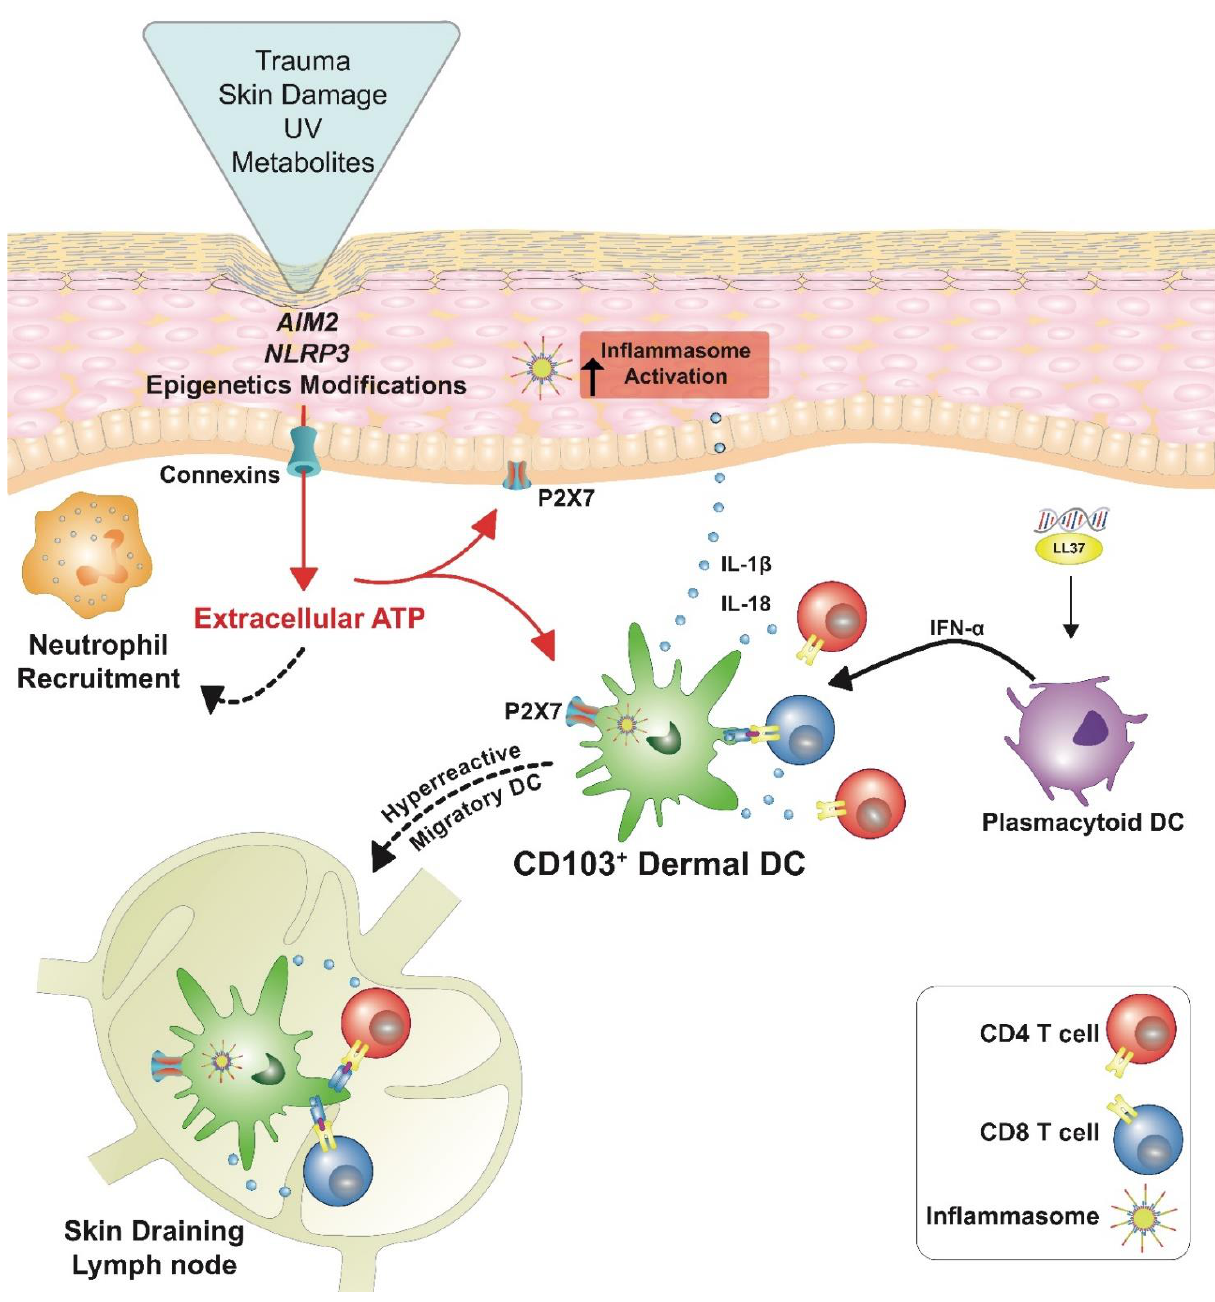
Figure 2. Hypothetical model for the early phase of psoriasis. An initial skin damaging event, caused by mechanical trauma, UV irradiation, or the accumulation of cell metabolites in the presence of susceptibility gene variants or epigenetic modifications, induce ATP release, both by cell membrane damage and connexin activation. Extracellular ATP may act as a chemotactic stimulus for immune cells and activate the inflammasome by binding the P2X7 receptor in keratinocytes and in CD103 + dermal DCs. This stimulates the production of IL-1 β and IL-18 and hyper migration of CD103 + dermal DCs to the skin draining lymph-node, where they present antigens to CD4 + and CD8 + T lymphocytes.